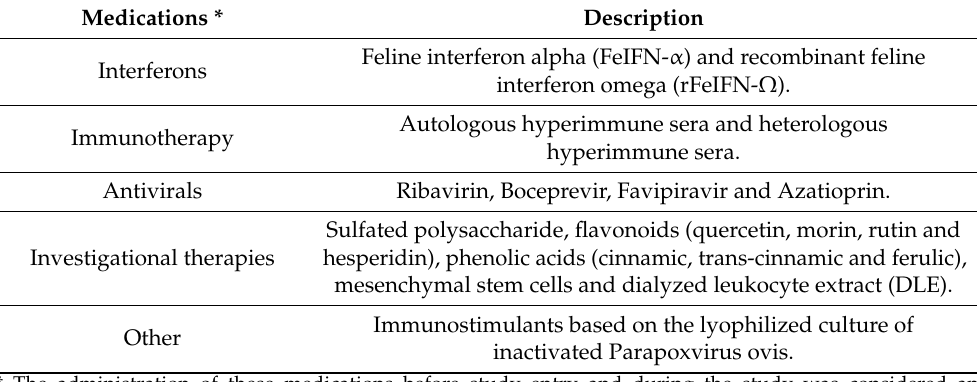
Table 1. Prohibited medications during the study. Medications